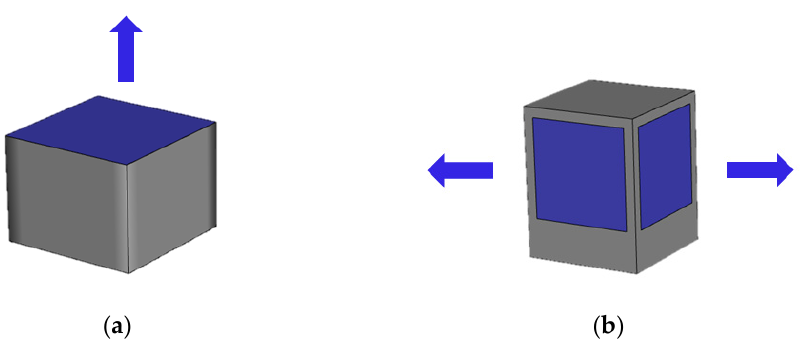
Figure 1. Diagram of an upper vent: ( a ) vertical discharge pattern; ( b ) horizontal discharge pattern.